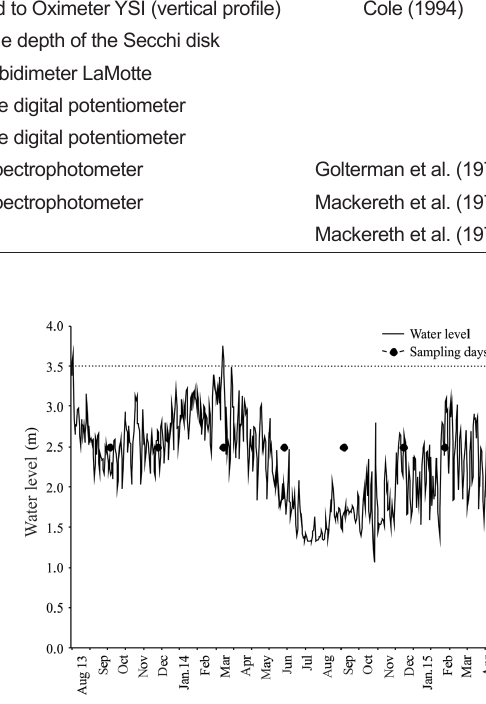
Figure 2. Water level of the Paraná River (continuous line) from August 2013 to May 2015. Points indicate sampling days. The dotted line indicates the limit (3.5 m) above which the high water period is